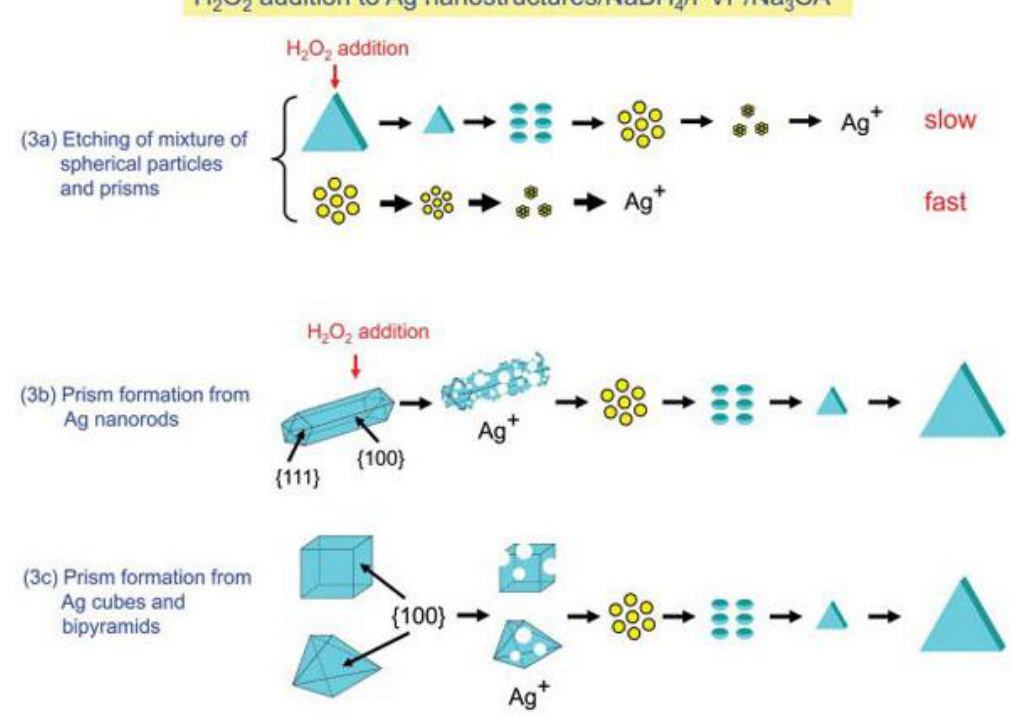
Figure 8. Growth mechanisms of ag nanostructures prepared from mixtures of spherical nanoparticles and prisms and nanorods, cubes, and bipyramids (reprinted with permission from [66]. Copyright (2012) American Chemical